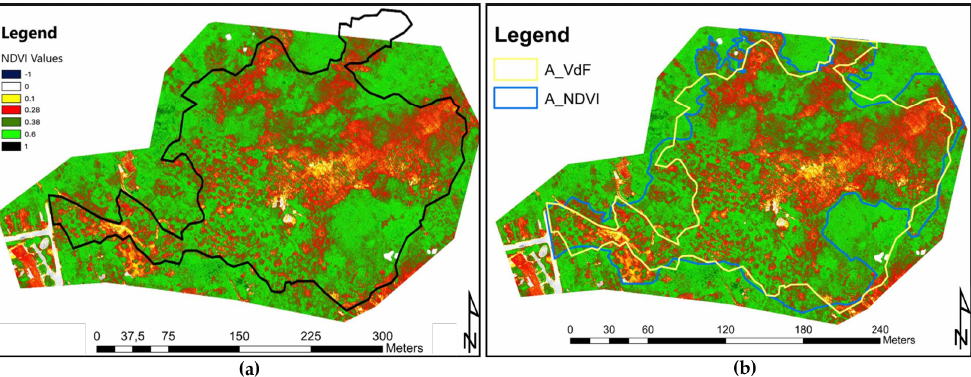
Figure 16. ( a ) Computed NDVI index on the area orthophoto. ( b ) Comparison of the burned area mapped via the field GPS by VdF personnel (yellow polygon), and area mapped by the drone-acquired data (blue polygon).